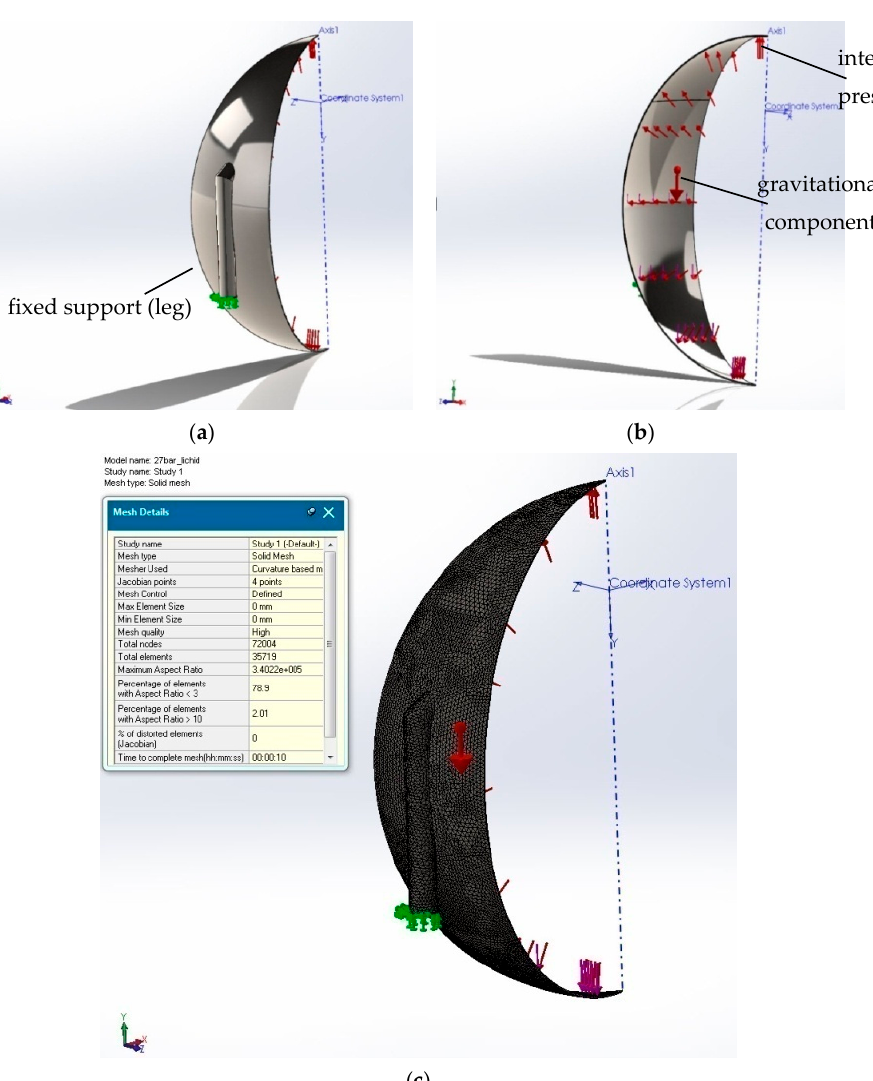
Figure 2. 3D model of the “slice part” option simulation parameters: ( a ) SolidWorks representation rules concerning the boundary conditions in terms of the degrees of freedom, ( b ) SolidWorks representation rules concerning the boundary conditions in terms of the loading parameters, and ( c ) 3D modeling using symmetry FEM meshing with 35,719 elements for each slice part.